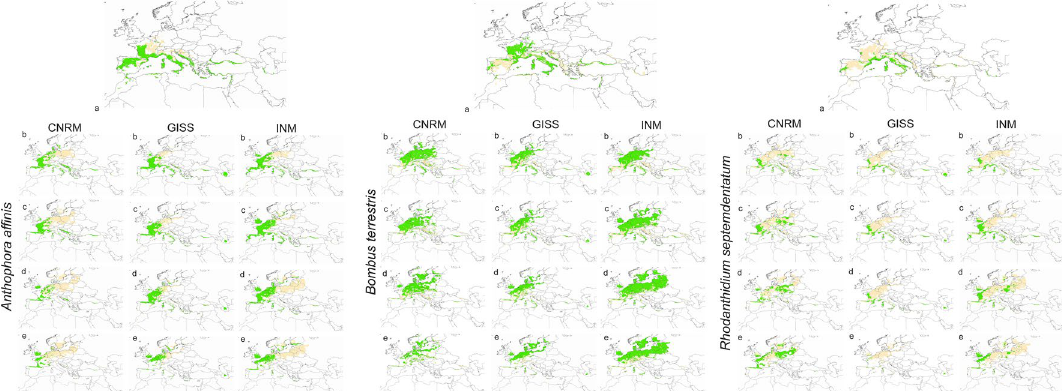
Figure 4. Presence of pollinator within L. abortivum range . Areas of overlap between pollinator and orchid range marked with green, areas suitable only for an orchid occurrence marked in sand yellow. ( a ) present